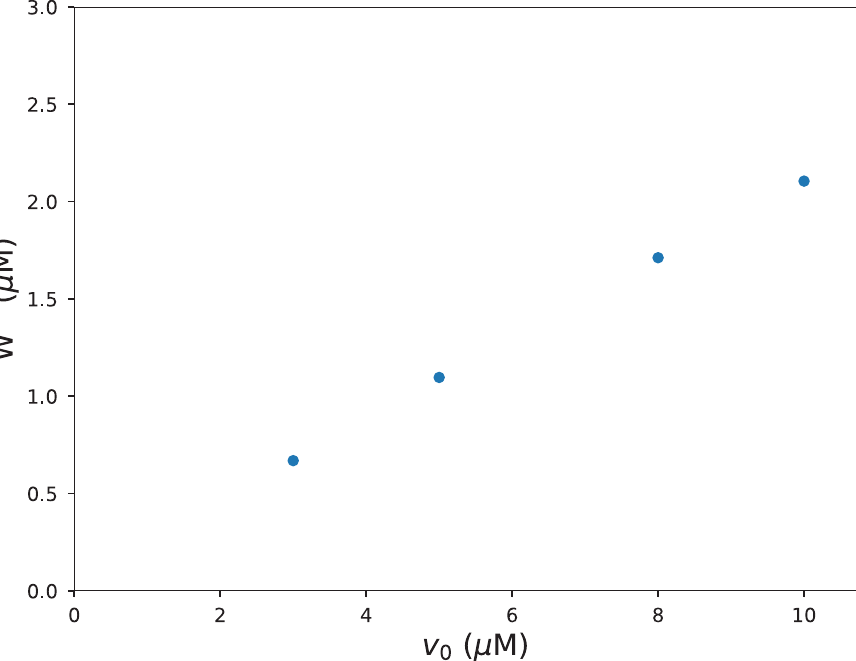
Fig 7. The extrapolated total drug concentration at an exchange area of 120 cm 2 as a function of the incoming drug concentration v 0